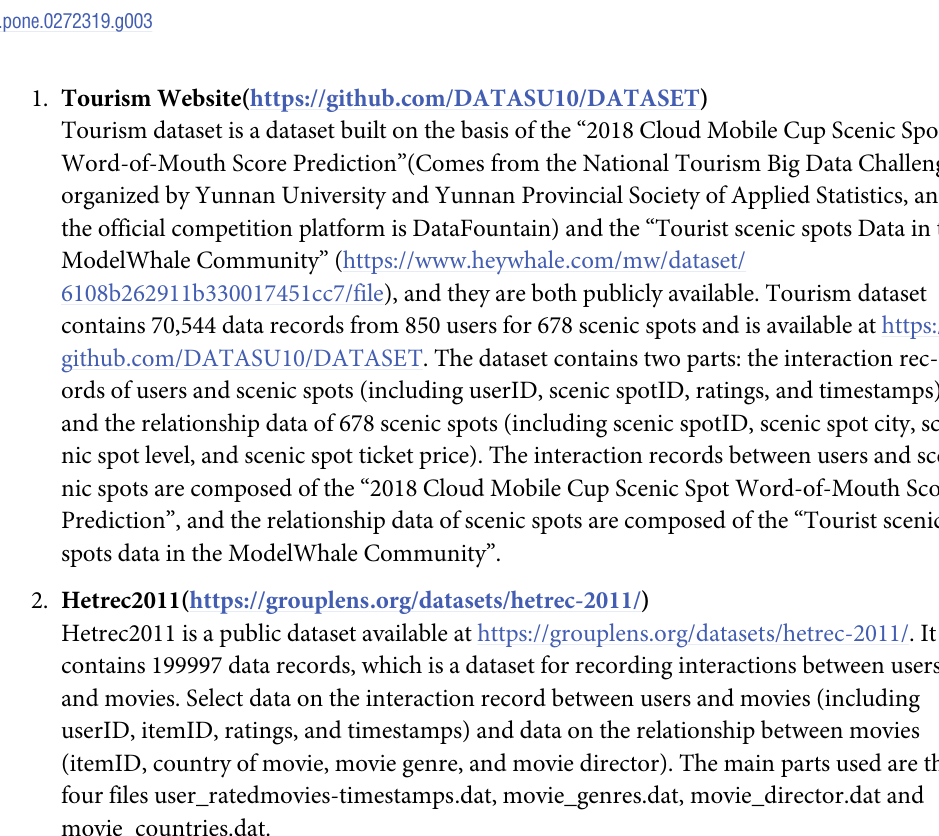
Fig 3. Structural diagram of this paper. The upper half of the diagram is composed of modelling the users’ long- and short-term intentions and the lower half is the modelling of the item relationships. The self-attention mechanism is adopted to analyse the users’ short-term intentions, and the Euclidean distance is applied to simulate the influence of long- and short-term